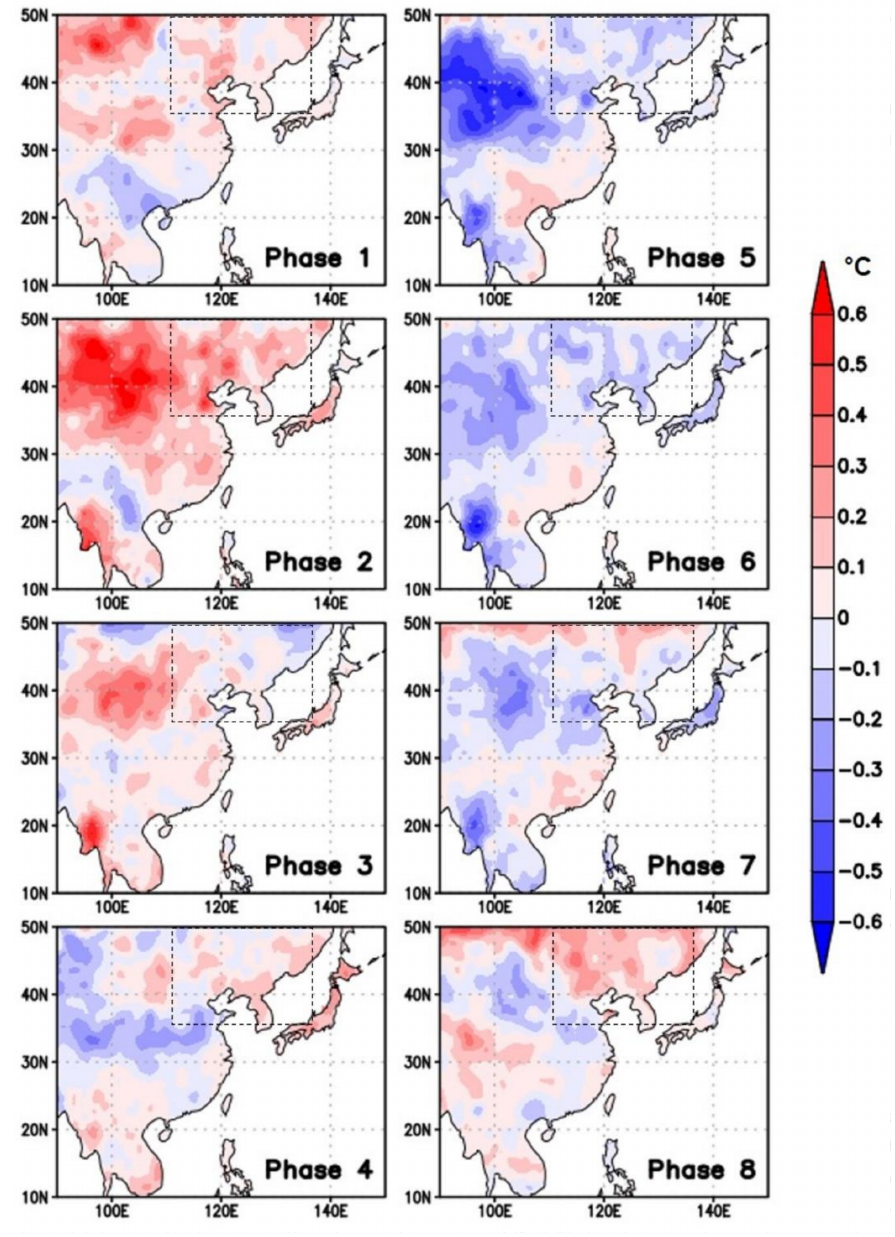
Figure 3. Composites of 30–90 days filtered surface air temperature (SAT) based on each of eight MJO phases during 22 spring seasons (April–May) of 1991–2012. Dashed rectangles indicate the domain of northeast